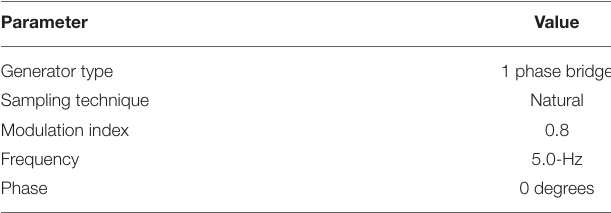
TABLE 4 | Parameters of simulated pulse generator for down-frequency